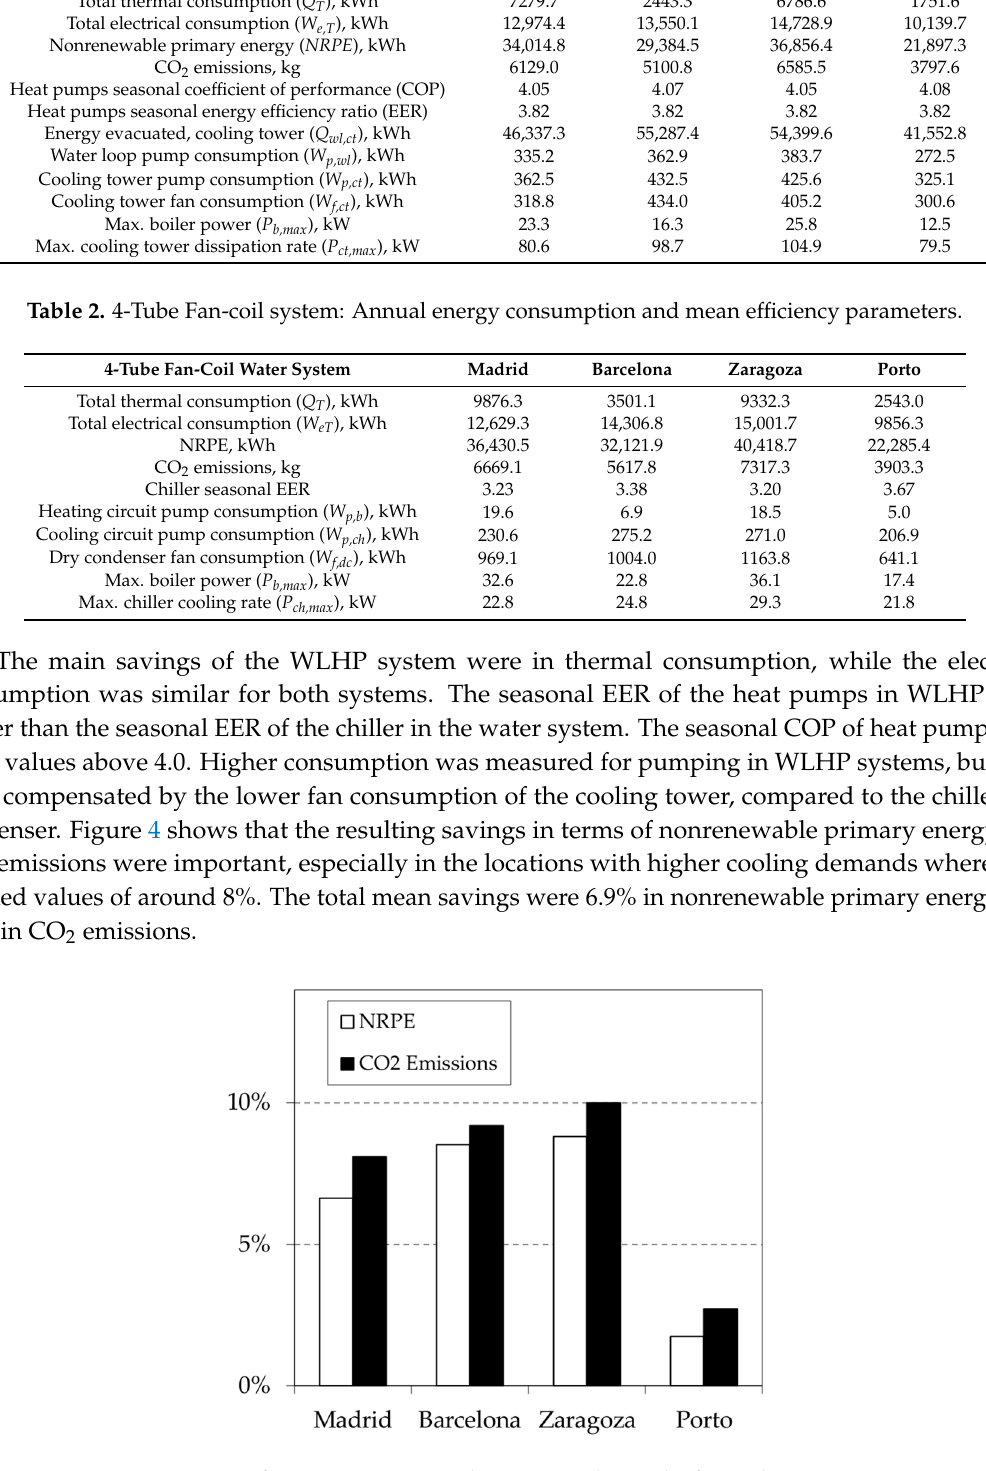
Table 1. WLHP system: Annual energy consumption and mean efficiency parameters.